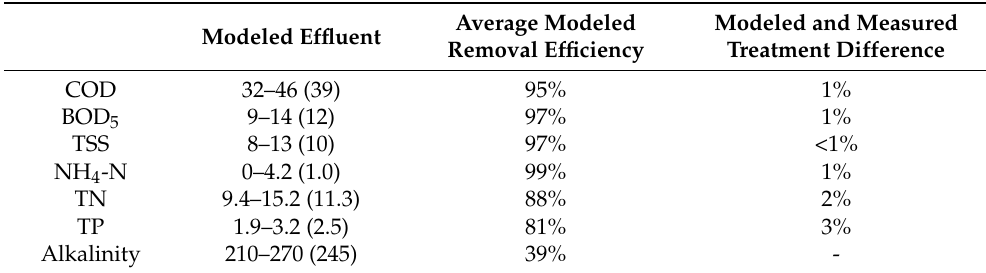
Table 4. Modeled treated effluent data in mg/L, the averages are in brackets and treatment efficiency as a percentage.